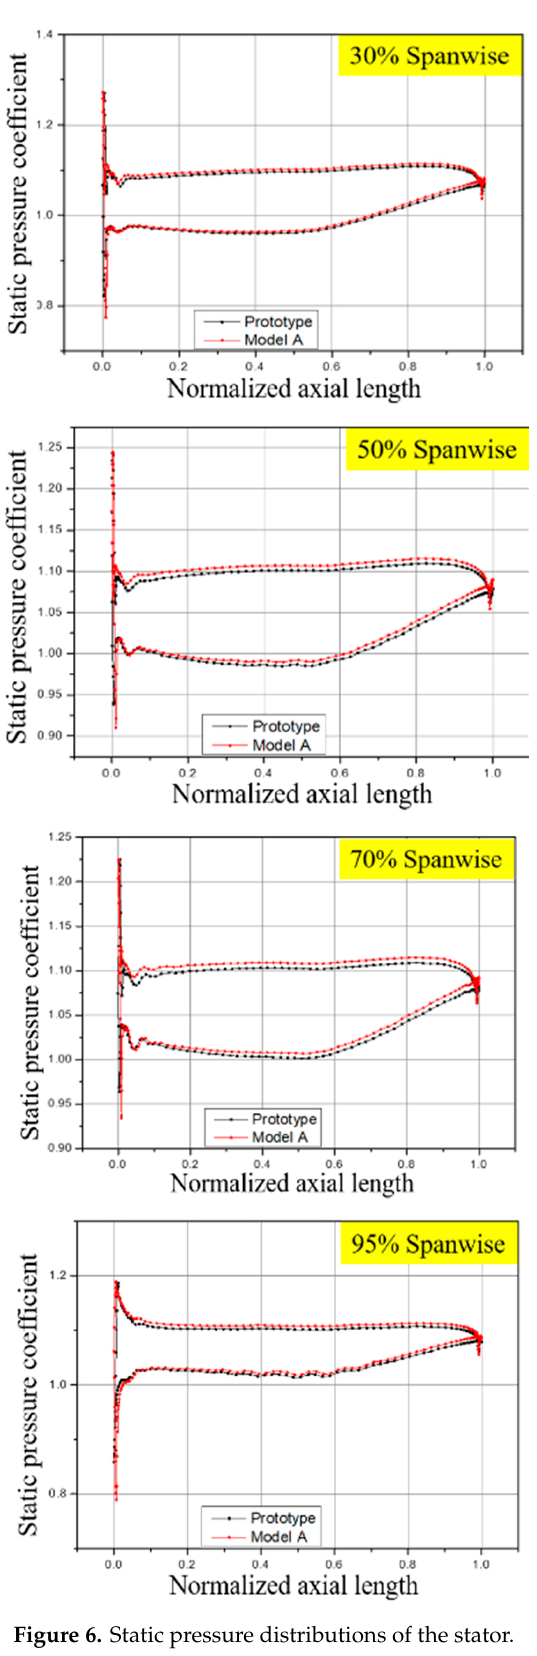
Figure 6. Static pressure distributions of the stator.